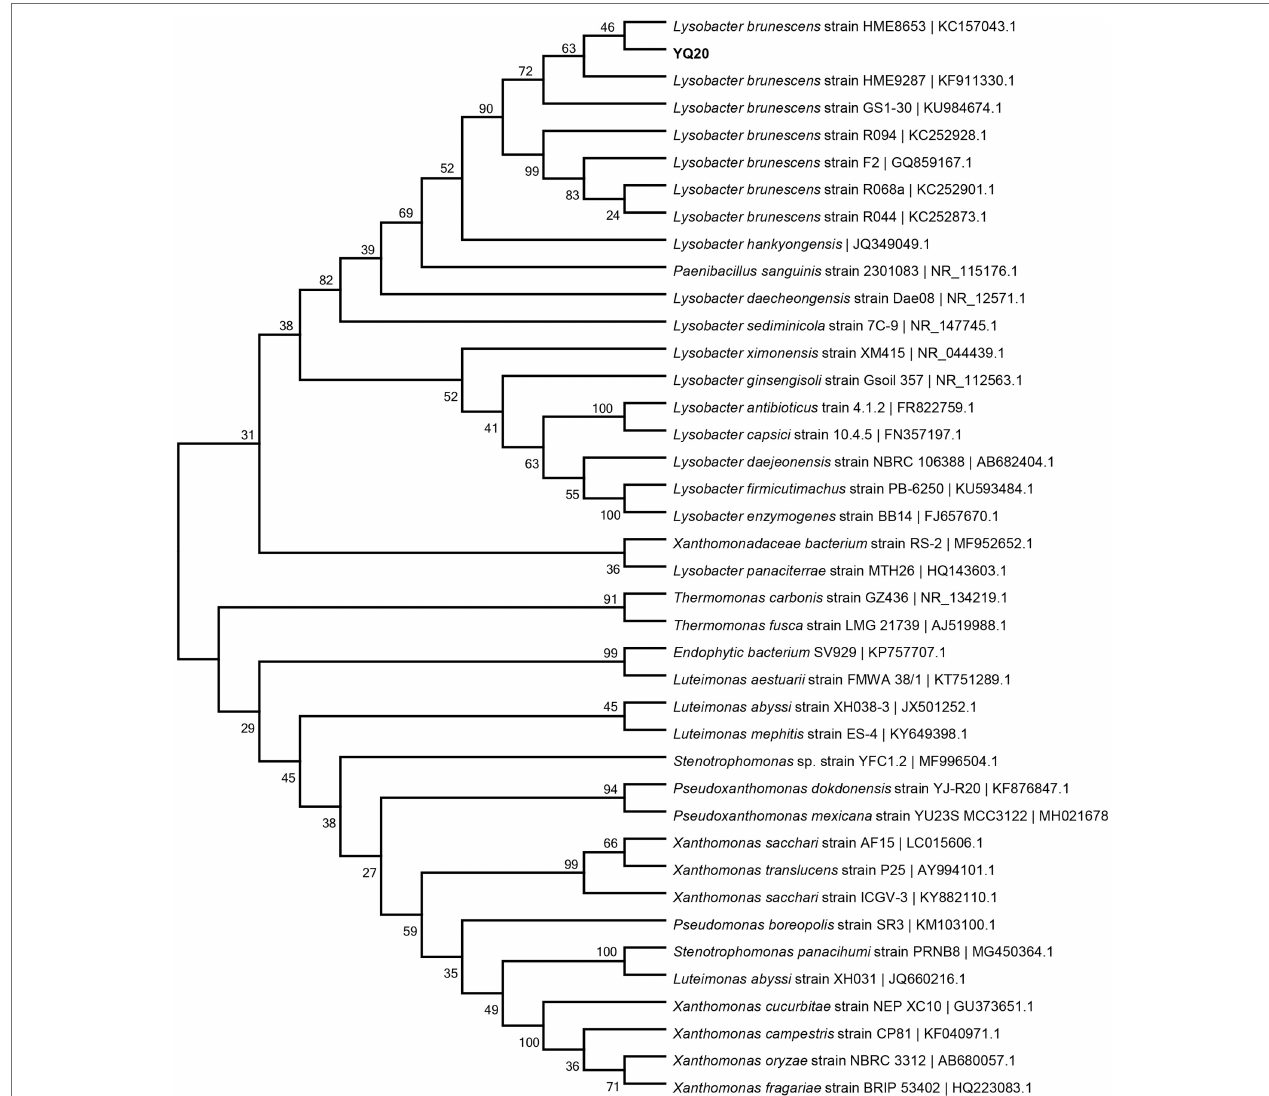
FIGURE 2 | Phylogenetic tree of YQ20. The branching pattern was generated by the neighbor-joining tree method. The GenBank accession numbers of the 16S rRNA nucleotide sequences are indicated in